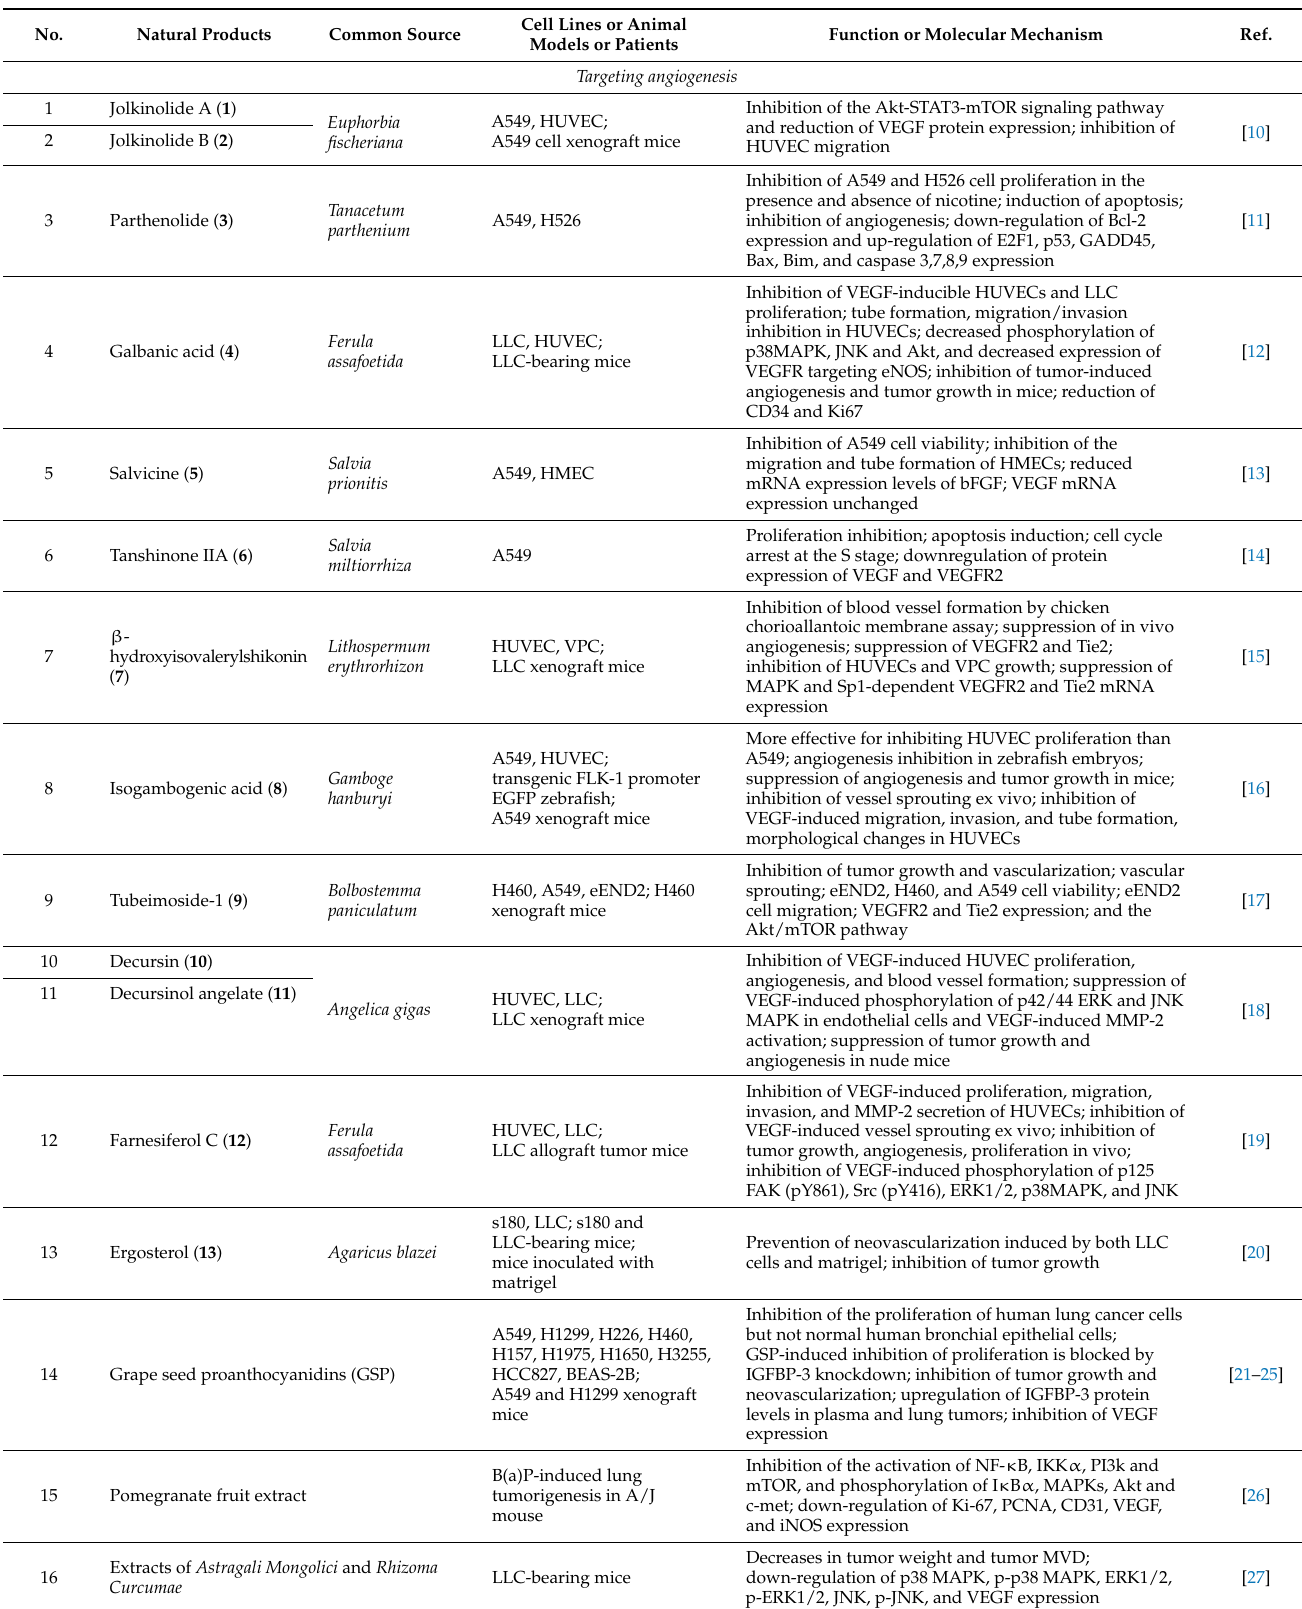
Table 1. The effects of natural products on modulation of the